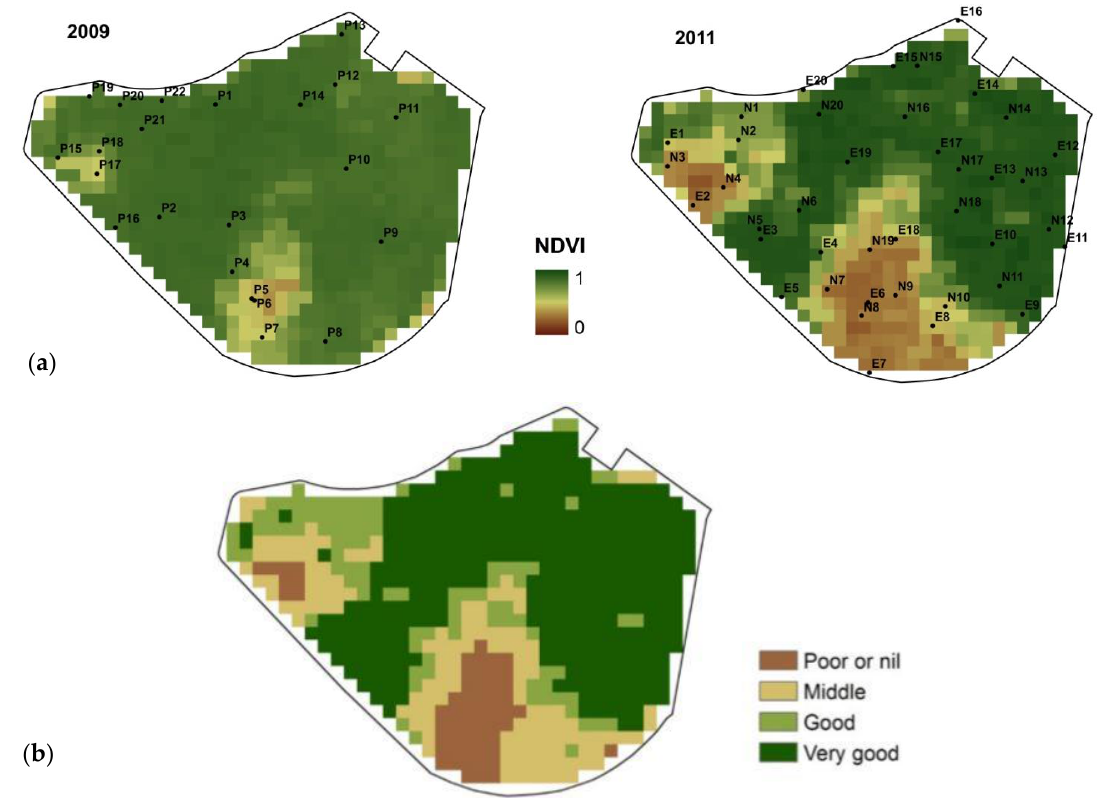
Figure 5. Vegetative activity in April for each year studied ( a ); and zonification of vegetative activity ( b ). Table 4. Statistics of the four vegetative development groups (Very good, Good, Middle, and Poor or nil) established according to NDVI.